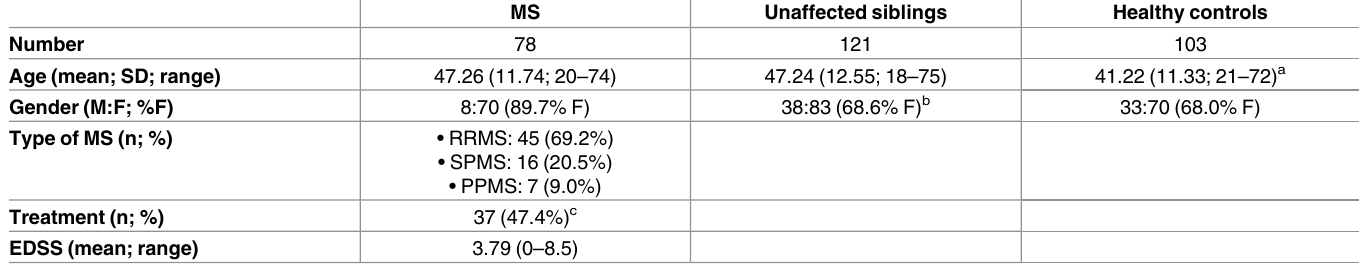
Table 1. Details of